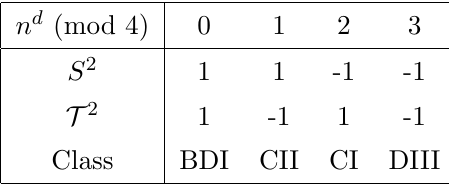
Table 2 . Symmetry classes of Gurau-Witten Hamiltonians with odd m and for arbitrary n .